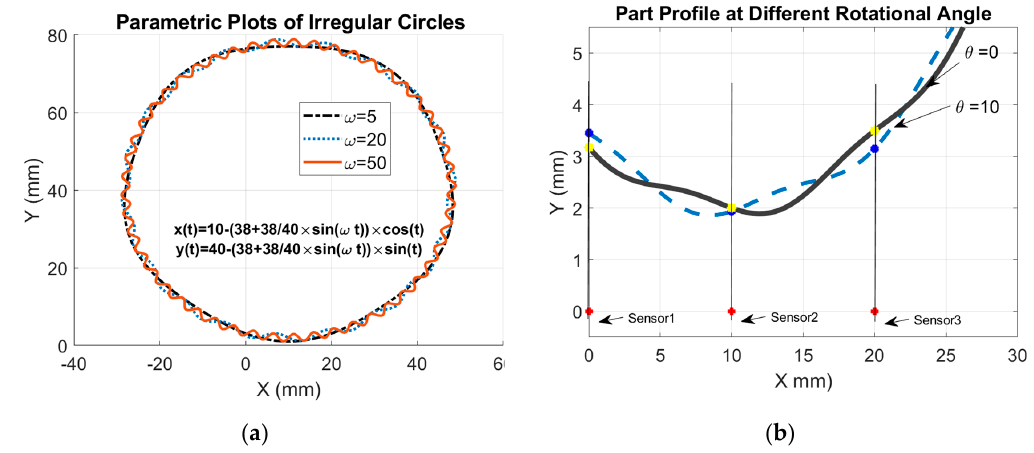
Figure 9. Mathematical representation of the inspected part with perturbation: ( a ) perturbed parts and ( b ) rotation of the inspected part at two angle, θ = 0 ◦ and θ = 10 ◦ .